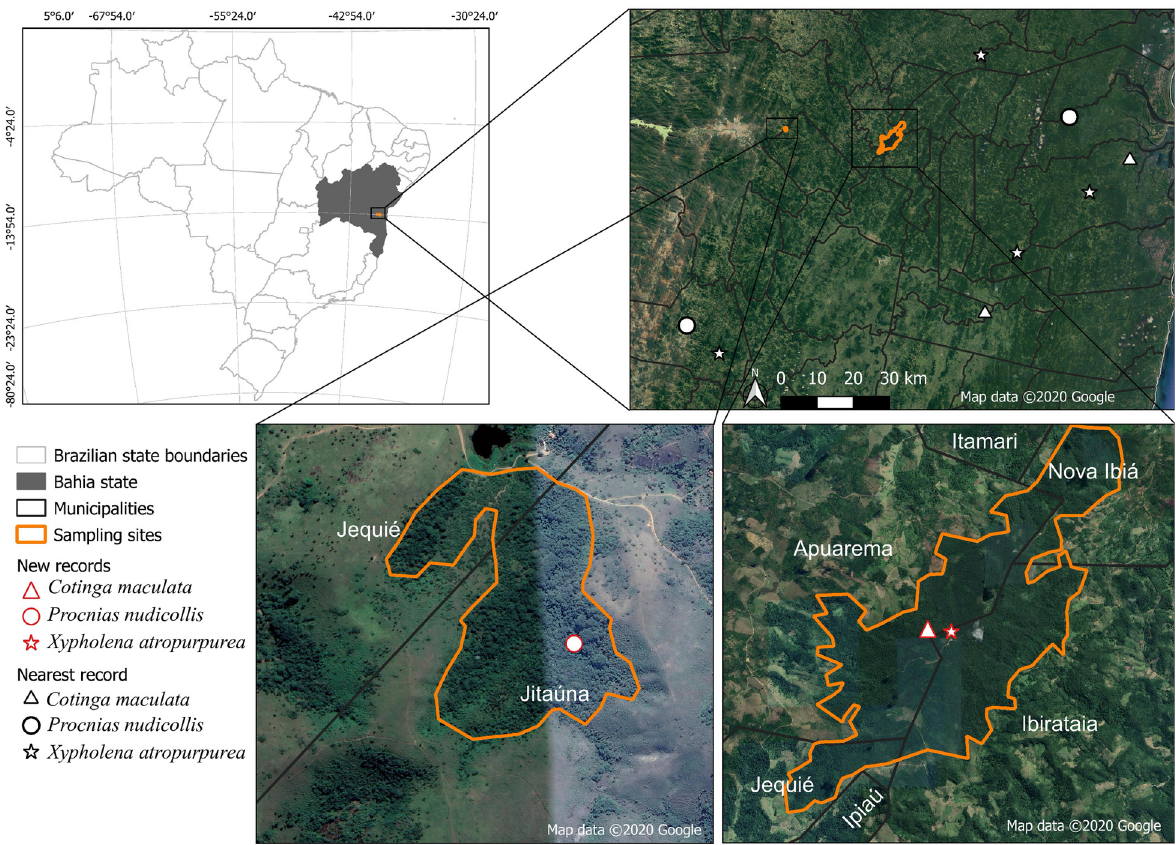
Figure 1. New records of threatened cotingas in Brazilian Atlantic Forest, with the nearest previous records